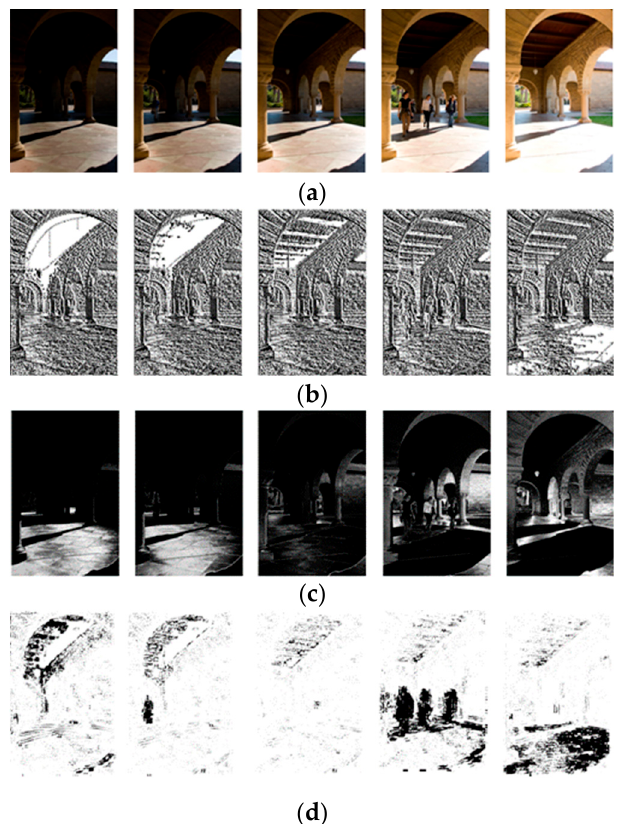
Figure 3. Comparison of different weights. ( a ) Source image sequence “Arch”. ( b ) Texture weights. ( c ) The brightness weights. ( d ) The spatial consistency weights.